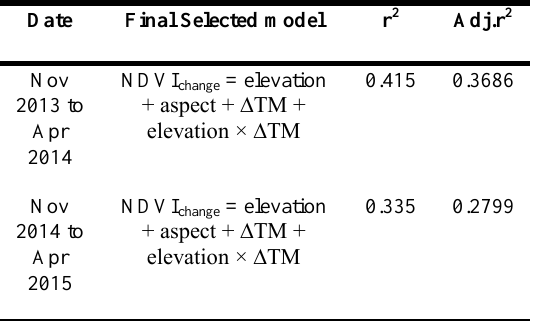
Table 2: Final selected models for Nov 2013 to Apr 2014 and Nov 2014 to Apr 2015 timelines